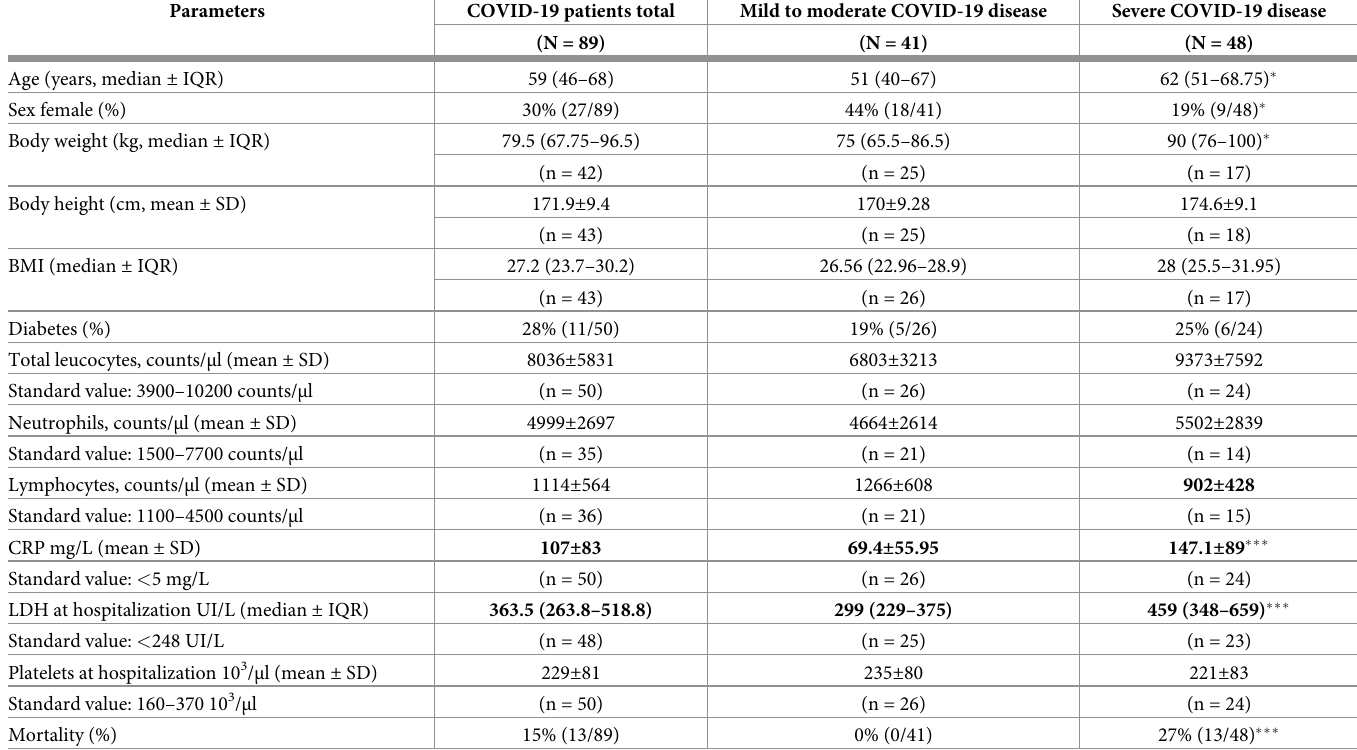
Table 1. Summary of clinical data of the COVID-19 patients.